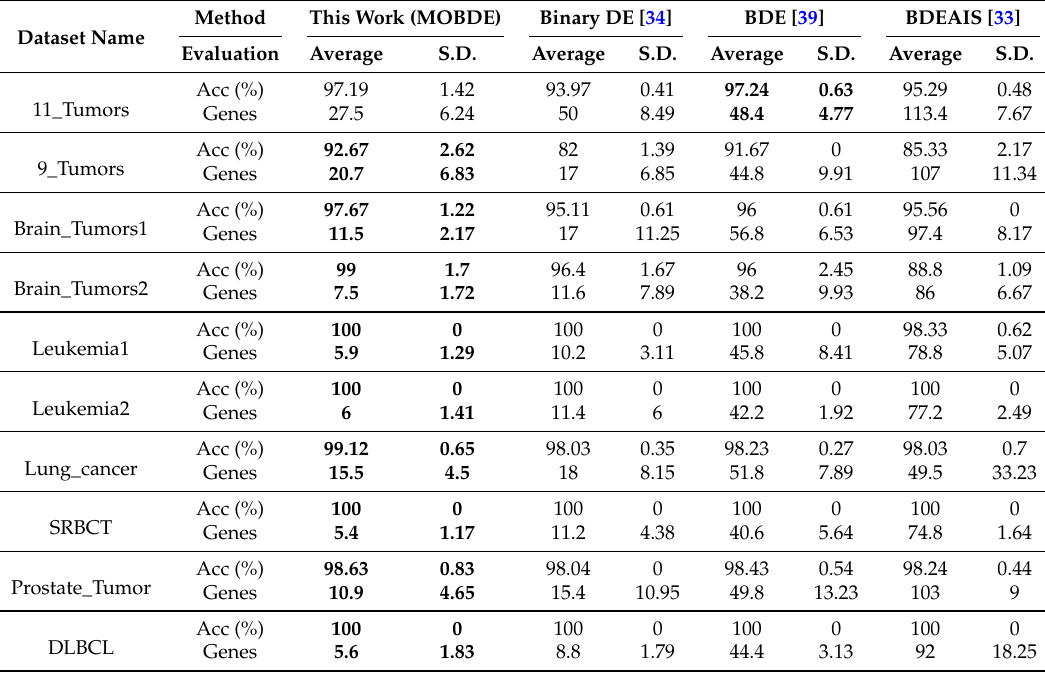
Table 7. Comparative experimental results of different binary differential evolution